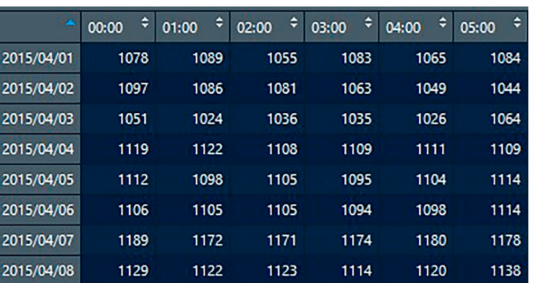
Figure 8. Part of the data frame of the 366 × 24 order